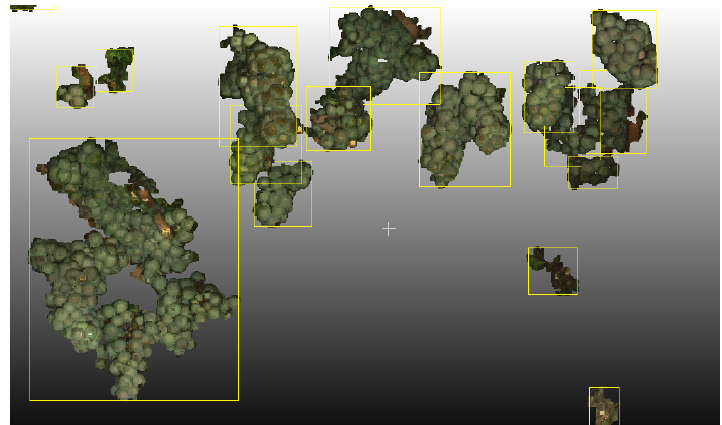
Figure 17. Components detected, indicated by a yellow bounding